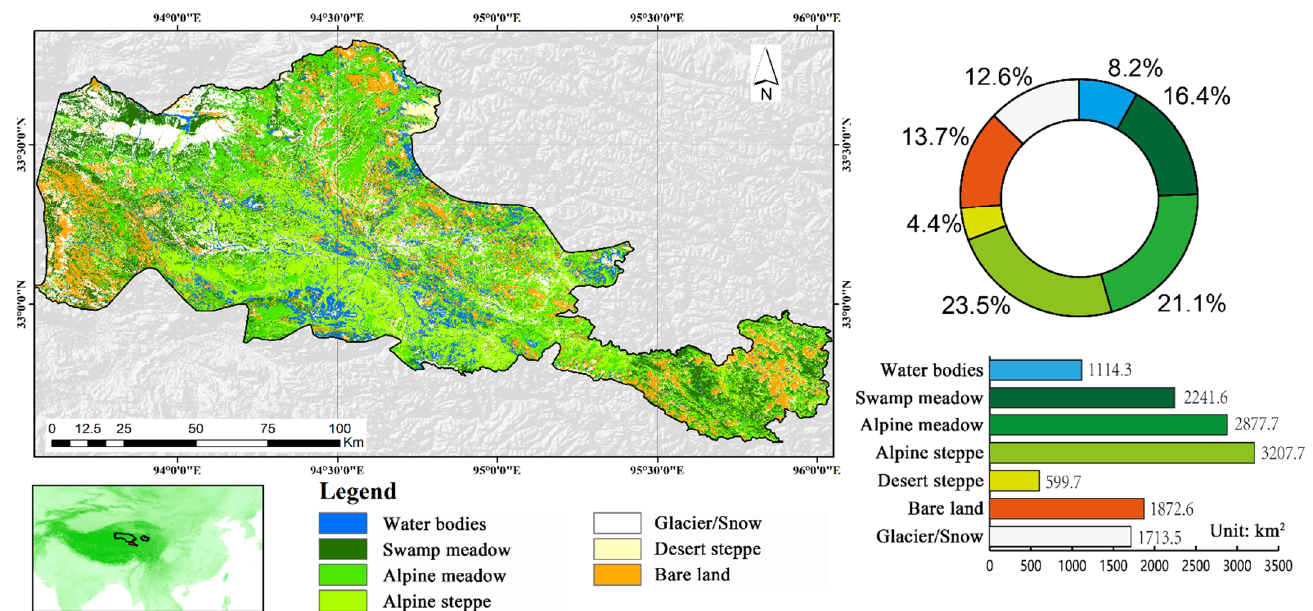
Figure 10. Vegetation classification results of 2021 in the headwater of the Lancang River in San- jiangyuan National Park.